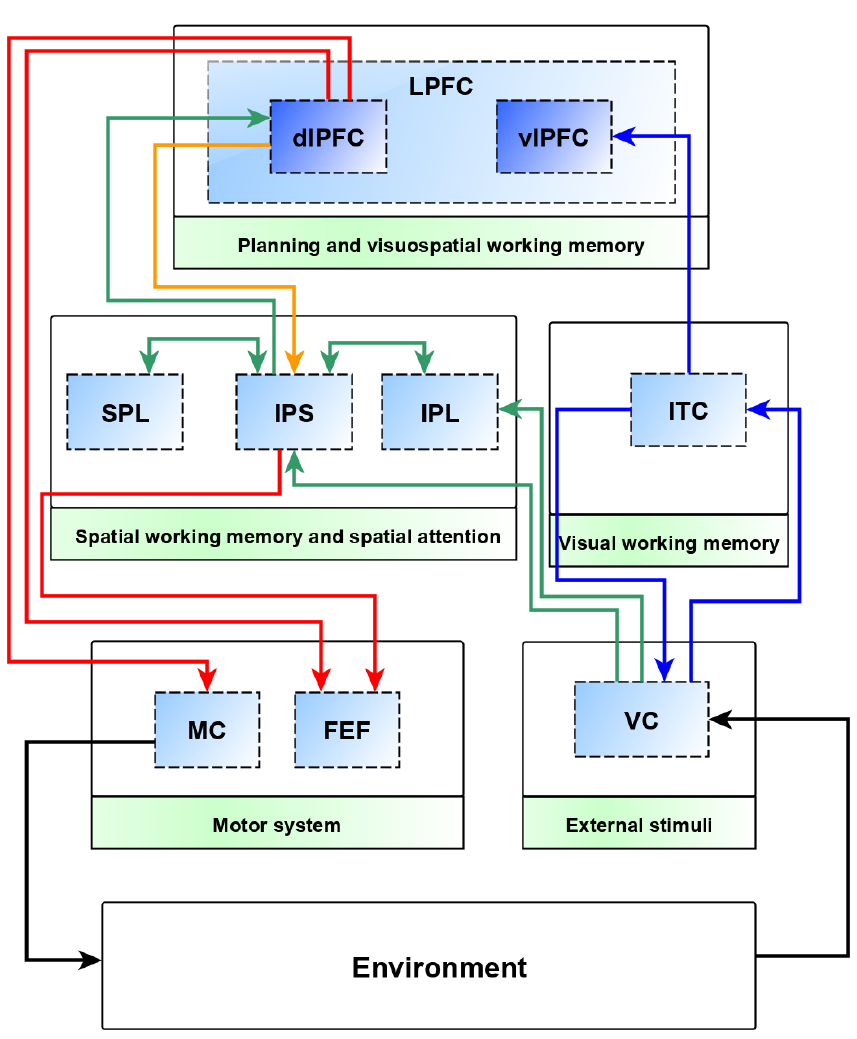
Figure 2. The architectonic design of the bio-inspired VSWM computational model.